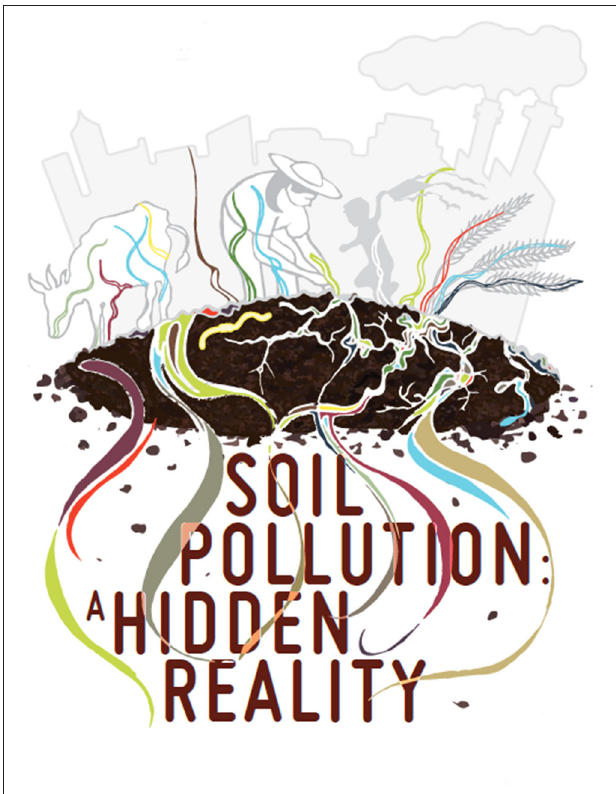
FIGURE 1 | Book cover of soil pollution: A hidden reality [Source: Food and Agriculture Organization of the United Nations (FAO). Reproduced with